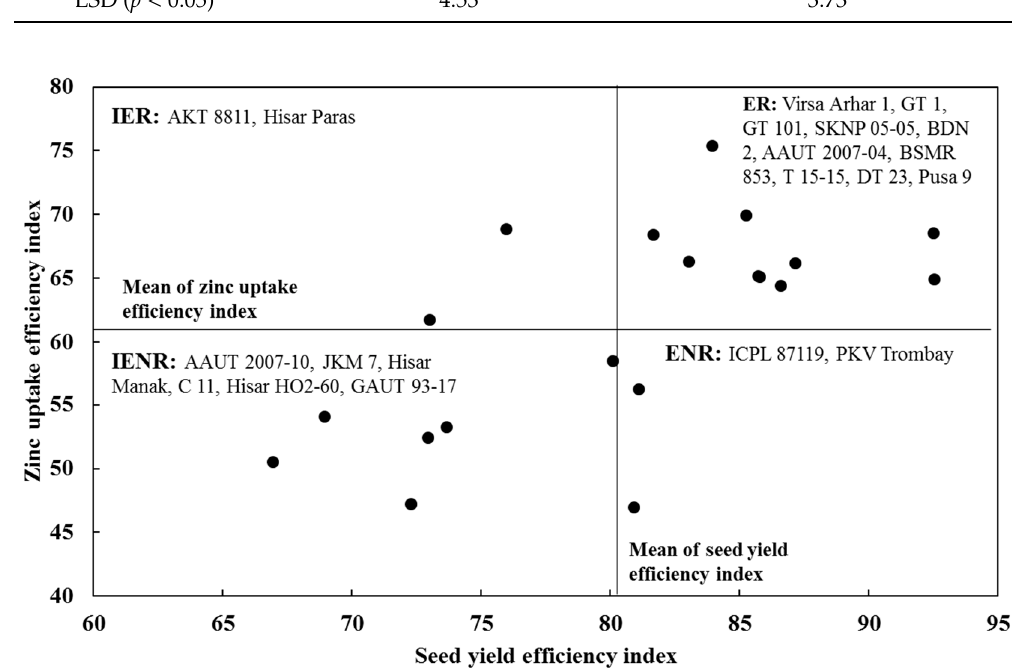
Figure 4. Classification (with 95% confidence interval) of pigeonpea genotypes for zinc (Zn) efficiency. ER = efficient and responsive, ENR = efficient and non-responsive, IER = inefficient and responsive, IENR = inefficient and non-responsive.